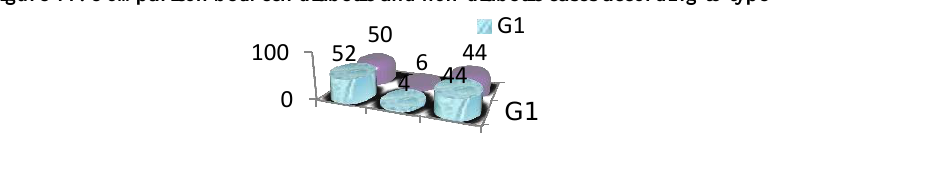
Figure 11: Comparison between diabetic and non-diabetic cases according to type